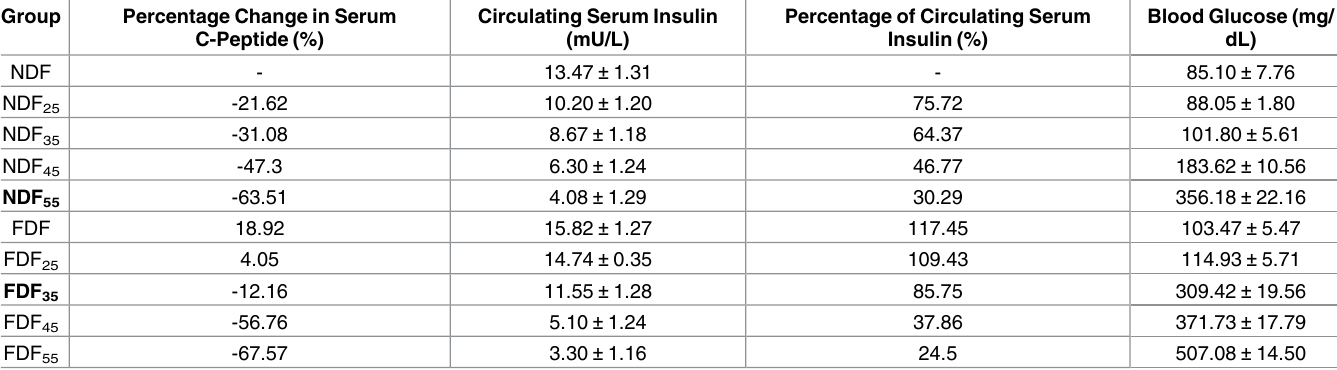
Data are presented as mean ± SD of 6–8 animals per group. NDF: Group fed with Normal Diet Feed + water and treated with normal saline as control. NDF 25 : Group fed with Normal Diet Feed + Water and treated with 25mg/kg bw, STZ.; NDF 35 : Group fed with Normal Diet Feed + Water and treated with 35mg/kg bw, STZ.; NDF 45 : Group fed with Normal Diet Feed + Water and treated with 45mg/kg bw, STZ; NDF 55 : Group fed with Normal Diet Feed + Water and treated with 55mg/kg bw, STZ.; FDF: Group fed with Fortified Diet Feed + 20% fructose and treated with Normal saline; FDF 25 : Group fed with Fortified Diet Feed + 20% fructose and treated with 25mg/kg bw STZ; FDF 35 : Group fed with Fortified Diet Feed + 20% fructose and treated with 35mg/kg bw STZ; FDF 45 : Group fed with Fortified Diet Feed + 20% fructose and treated with 45mg/kg bw STZ; FDF 55 : Group fed with Fortified Diet Feed + 20% fructose and treated with 55mg/kg bw